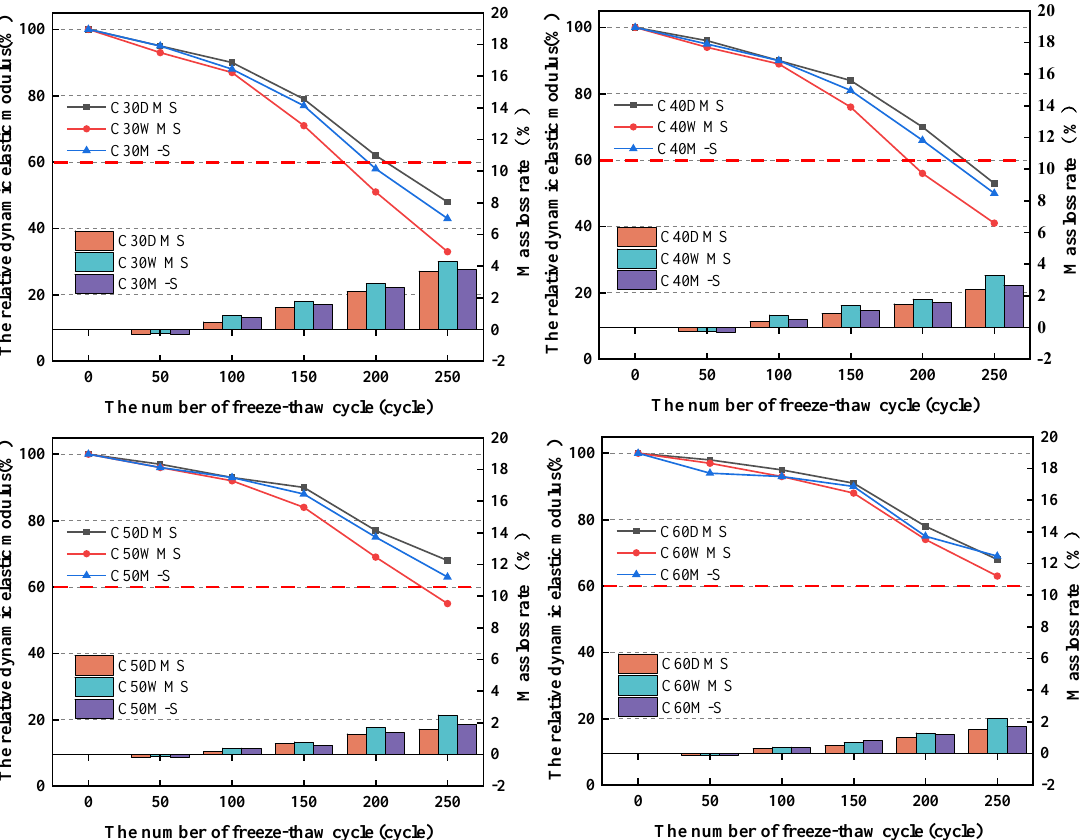
Figure 15. Relative dynamic elastic modulus and mass loss in each group. According to the requirements of GB/T50082-2009, freeze thaw cycle test stop when the relative dynamic elastic modulus of specimen lower than 60%, which is lower than the rad dotted line in the figure)